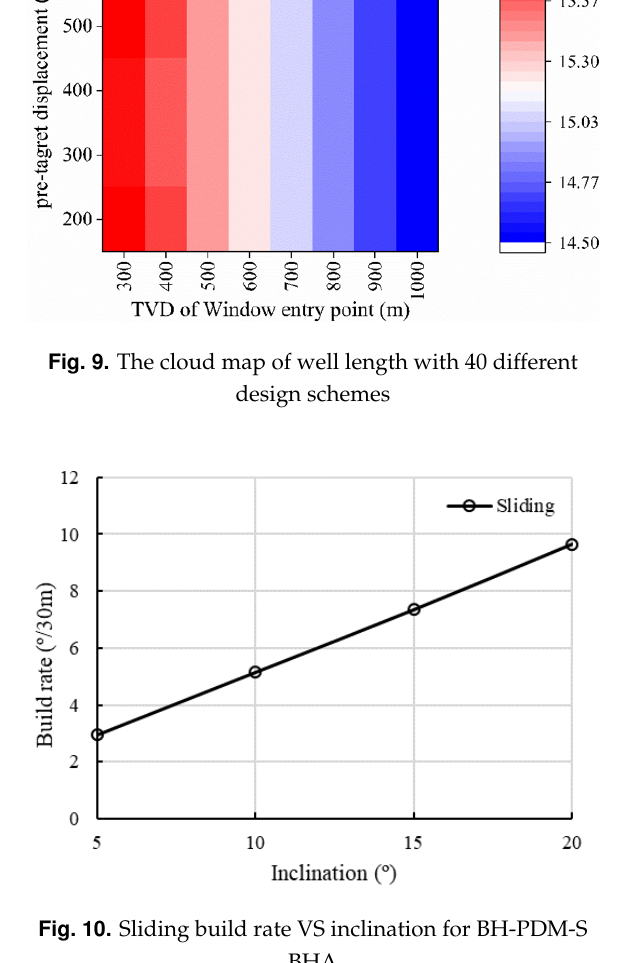
BH-PDM-S BHA cannot effectively control drilling direc- tion while directional drilling. Replace a set of BH-PDM-D BHA with follows structure: Phi 333.4 mm bit + Phi 245 mm PDM(bend angle 1 °, with Phi 330 mm lower stabilizer) + Phi 228.6 mm NMDC + Phi 330 mm stabilizer + Phi